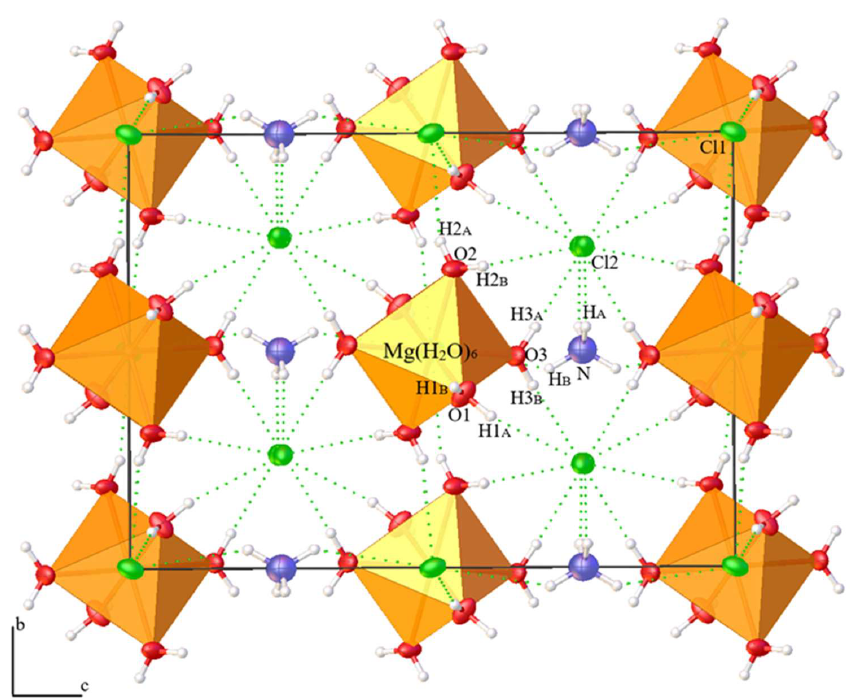
Figure 2. The crystal structure and hydrogen bonding of NH 4 MgCl 3 ·6H 2 O phase.